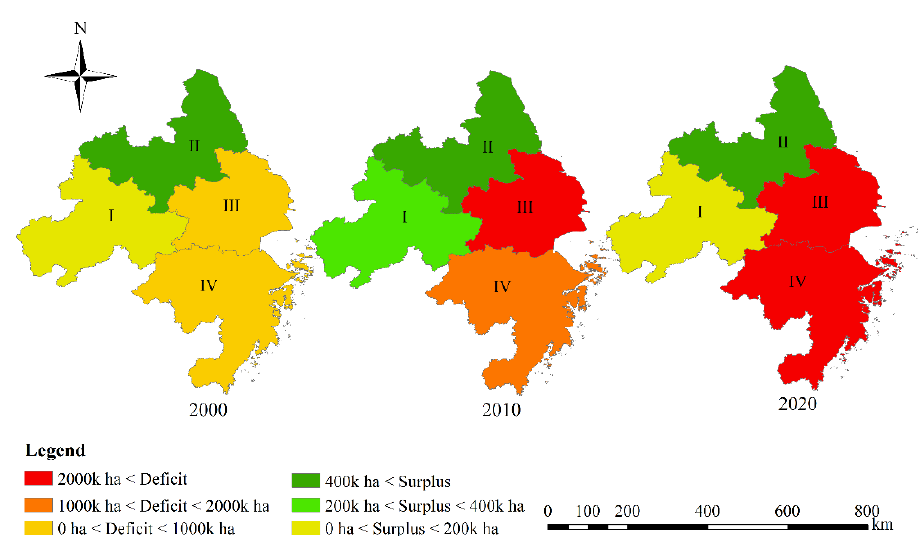
Figure 9. Spatial distribution of farmland-surplus subgroups and farmland-deficit subgroups.